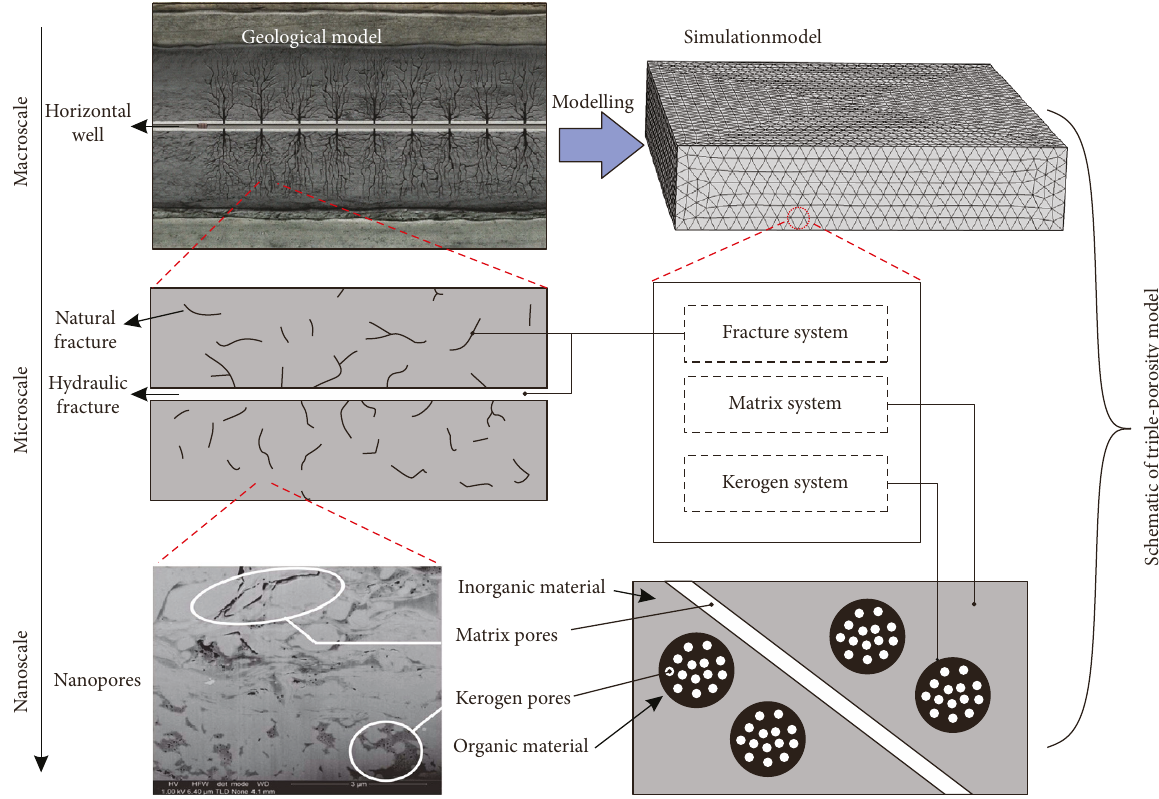
Figure 1: Conceptual triple-porosity model for shale gas reservoir at various scales (SEM image is from Ambrose et al. [13], fi gure in lower right is from Wasaki and Akkutlu